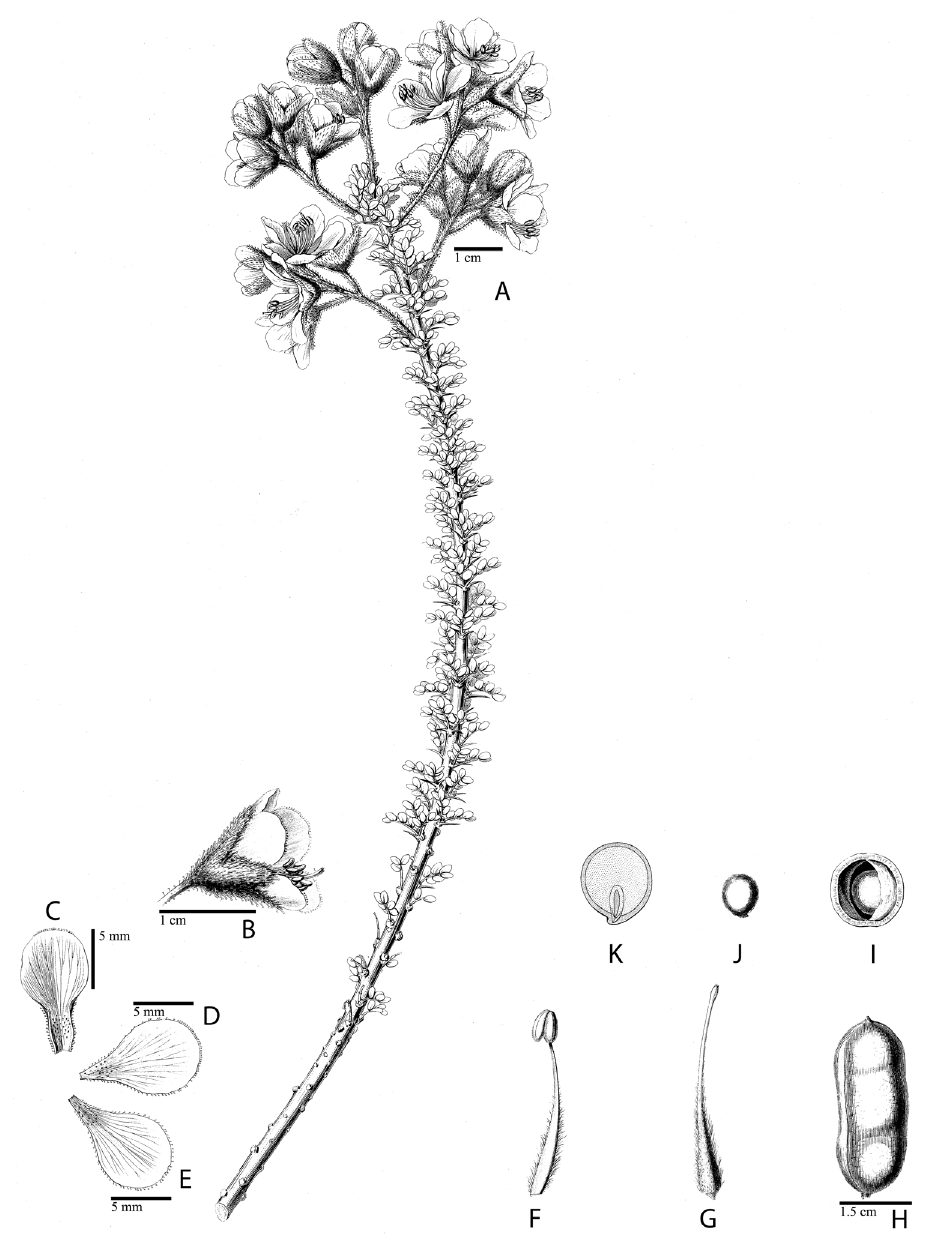
Figure 33. Balsamocarpon brevifolium Clos. A flowering stem B flower C median petal D upper lateral petal E lower lateral petal F stamen G gynoecium H fruit I dissected seed J longitudinal section of seed K embryo. Drawn by A. Riocreux, first published in Historia fysica y polica de Chile, Botanica, Atlas, col. 1: t. 20 (1854). Scale bars were estimated for this plate based on descriptions and comparison with herbarium specimens; we were unable to estimate these for F , G , K , J , I